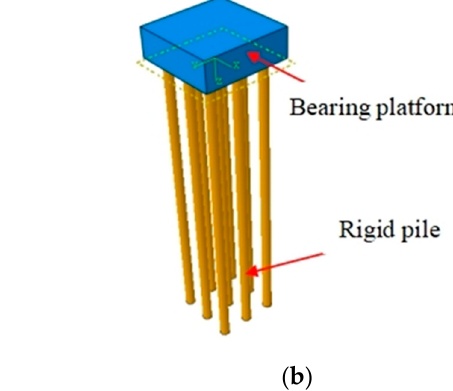
Figure 12. Finite element model of engineering case: ( a ) FEA model; ( b ) platform and pile model. Four cases are simulated by the finite element analysis, which are shown in Table 5.